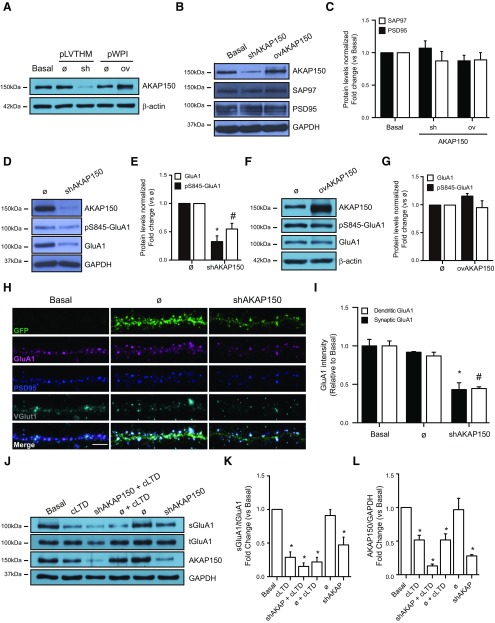
Silencing endogenous AKAP150 reduces AMPARs-GluA1 subunit levels. A, AKAP150 was silenced (sh or shAKAP150) or overexpressed (ov or ovAKAP150) in neuronal cultures after transduction with lentiviral vectors. Representative blot images showing the efficiency of shAKAP150 or ovAKAP150 transduction in primary neurons. Empty lentiviral vector (Ø; pLVTHM or pWPI) was used as a control. B, Silencing AKAP150 does not affect related scaffold proteins like PSD95 (∼95-kDa band) or SAP97 (∼140-kDa band). Representative blot images showing levels of AKAP150 (top panel; as a control of silencing or overexpressing), PSD95 and SAP97 when endogenous AKAP150 was knocked down (shAKAP150) or overexpressed (ovAKAP150). GAPDH (bottom panel) was used as a loading control. C, Quantification of PSD95 or SAP97 levels when AKAP150 was silenced (shAKAP150) or overexpressed (overAKAP150) normalized to basal (n = 4). D, Endogenous AKAP150 silencing reduces S845-GluA1 phosphorylation and total GluA1 protein. Representative blot images showing AKAP150 levels (top panel; as a control of silencing), phosphorylated GluA1 (pS845-GluA1), total GluA1 and GAPDH (bottom panel; loading control). E, Quantification in pS845-GluA1 and GluA1 levels in response to AKAP150 knock-down compared with basal (n = 3, *p = 0.0057 vs basal; #p = 0.0070 vs basal). F, AKAP150 overexpression does not modify S845-GluA1 phosphorylation and total GluA1 protein levels. Representative blot images showing AKAP150 (top panel; as a control of overexpression), phosphorylated GluA1 (pS845-GluA1), total GluA1 and GAPDH (bottom panel; loading control) levels. G, Quantification of pS845-GluA1 and GluA1 in response to AKAP150 overexpression compared with basal (n > 3). H, Representative confocal images of dendrites show GluA1 (magenta), presynaptic VGlut1 (gray), and postsynaptic PSD95 (blue) levels after knocking down AKAP150 compared with basal condition (Ø; empty vector). GFP expression (green) is used as a control of transduction. Down-regulation of endogenous AKAP150 reduced dendritic and synaptic GluA1 intensity. Bottom panels in H show the merge for GFP/GluA1/PSD95/VGlut1. I, Quantification of GluA1 (GluA1) intensity normalized to basal. AKAP150 knockdown expression reduced dendritic (o) and synaptic (ν) GluA1 (n > 30 dendrites of different neurons from five independent cultures, *p < 0.0001 vs basal; #p < 0.0001 vs basal). J, Surface GluA1 levels on cLTD in presence of shAKAP150. Representative blot images showing decreased levels of surface GluA1 after cLTD in presence of shAKAP150 (sGluA1; ∼110-kDa band, top panel) related to total GluA1 (tGluA1; ∼110-kDa band, middle panel). GAPDH was used as a loading control (∼36-kDa band, bottom panel). K, Quantification of surface GluA1 changes in response to cLTD in presence of shAKAP150 compared with basal condition (n = 3, *p = 0.0030 for cLTD, *p = 0.0012 for shAKAP150+cLTD, *p = 0.0018 for empty+cLTD and *p = 0.0141 for shAKAP150 vs basal). L, Quantification of AKAP150 in response to cLTD in presence of shAKAP150 compared with basal condition (n = 3, *p = 0.0080 for cLTD, *p < 0.0001 for shAKAP150+cLTD, *p = 0.0080 for empty+cLTD and *p = 0.0003 for shAKAP150 vs basal). Scale bars = 5 μm. Bars represent mean ± SEM.